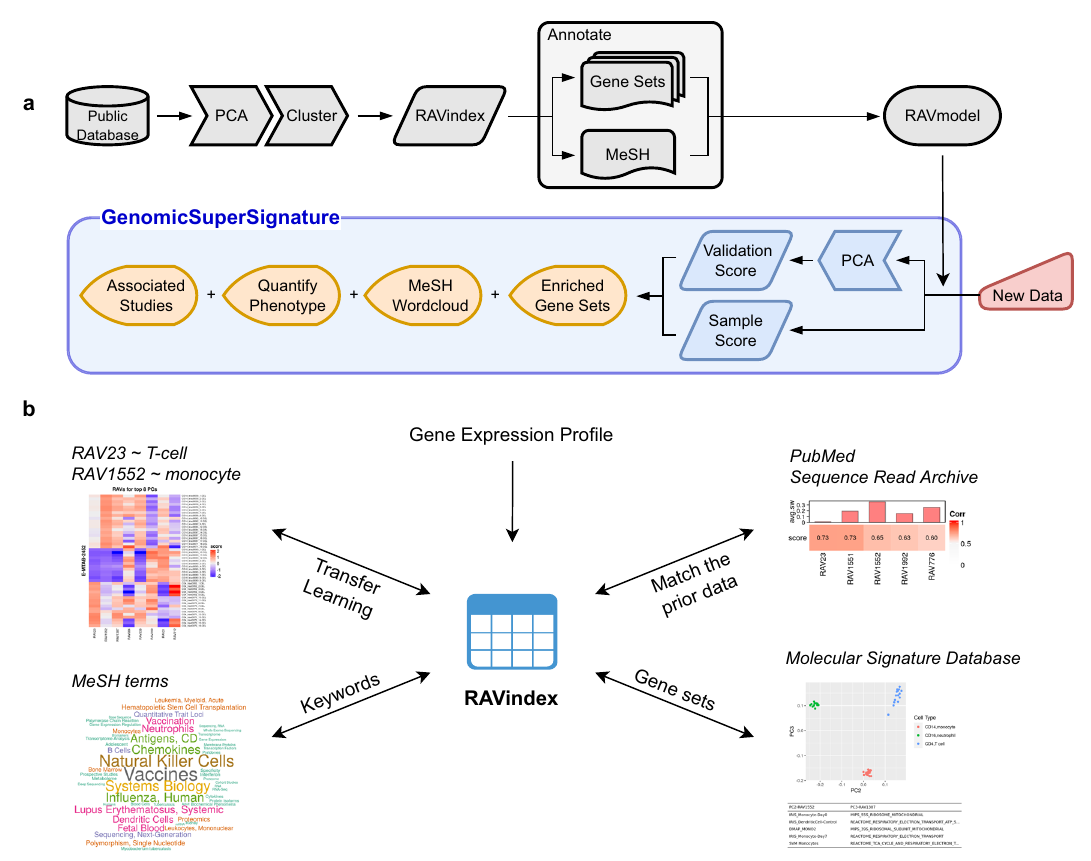
Fig. 1 Overview of GenomicSuperSignature. a Schematic illustration of RAVmodel construction and GenomicSuperSignature application. Building the RAVmodel (gray) was performed over several days on 24 cores with 128 Gb memory. Users can apply RAVmodel on their data (red) using the GenomicSuperSignature R/Bioconductor package (blue), which operates on a time scale of seconds for exploratory data analysis (orange) on a typical laptop computer. b Information assembled as RAVmodel, a single R object. RAVmodel connects different public databases and prior information through RAVindex (Supplementary Fig. 1b), creating the interconnected resources illustrated here. Through GenomicSuperSignature R/Bioconductor package and the accompanying RAVmodel, users can instantly access and explore the diverse public databases from multiple entry points such as gene expression pro fi les, publications, study metadata, keywords in MeSH terms and gene